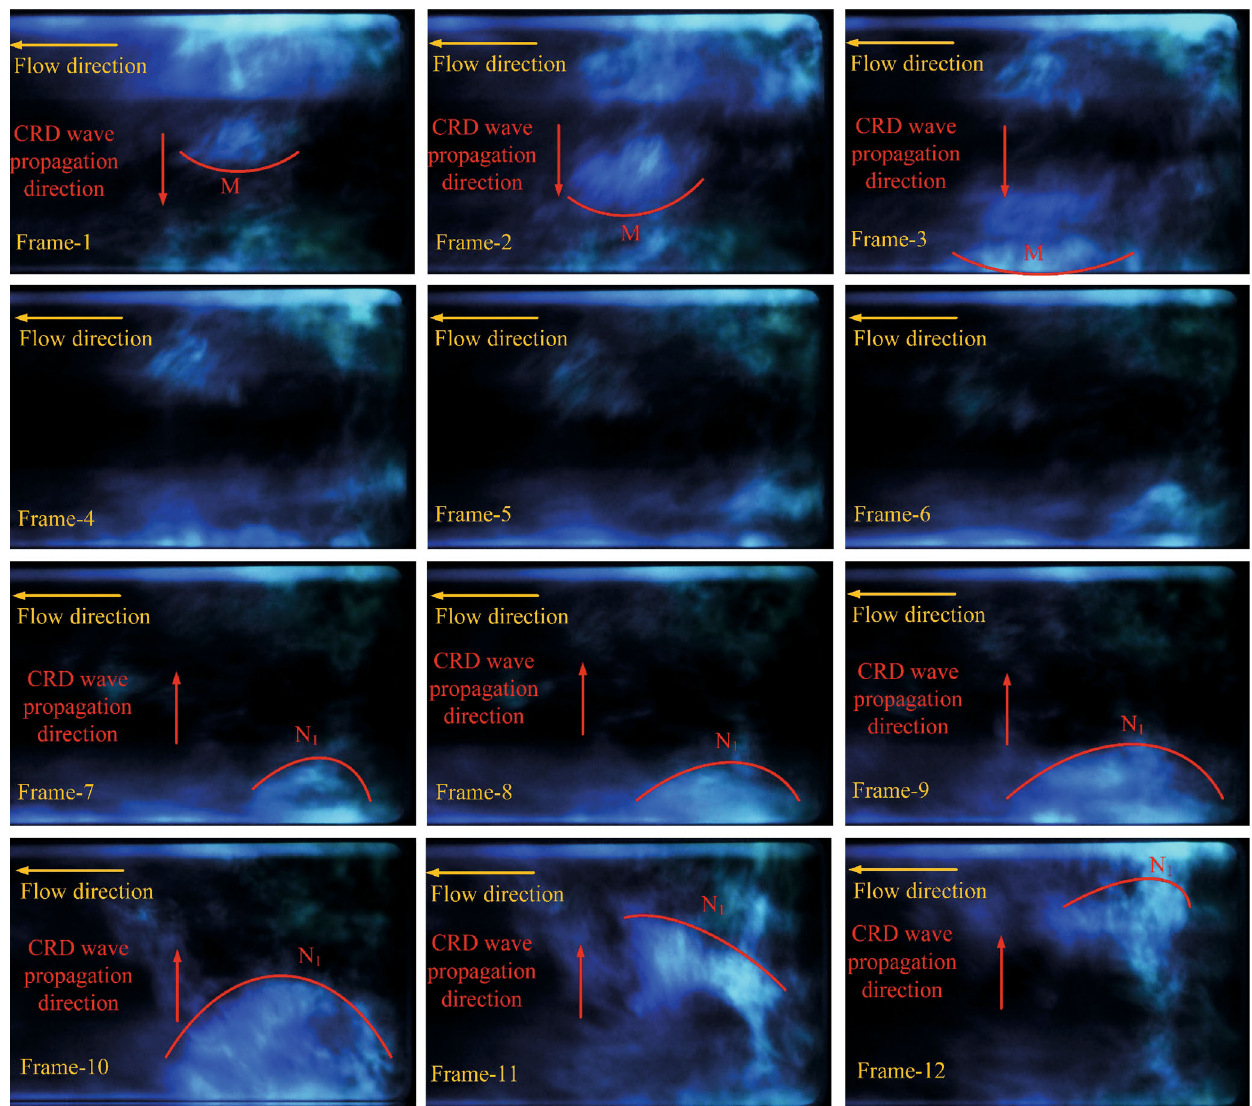
Figure 9: High-speed photography images of counter-rotating two-wave mode in Test